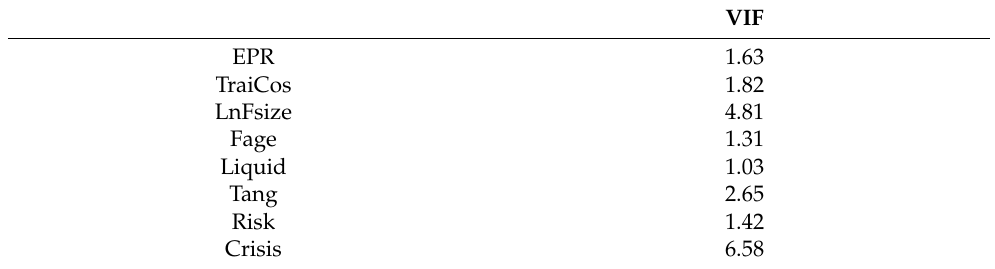
Table 3. Variance inflation factors.